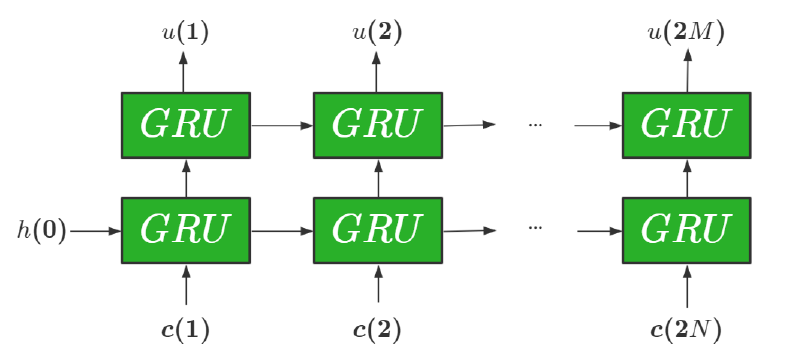
Figure 2. The schematic diagram of the GRU neural network structure.